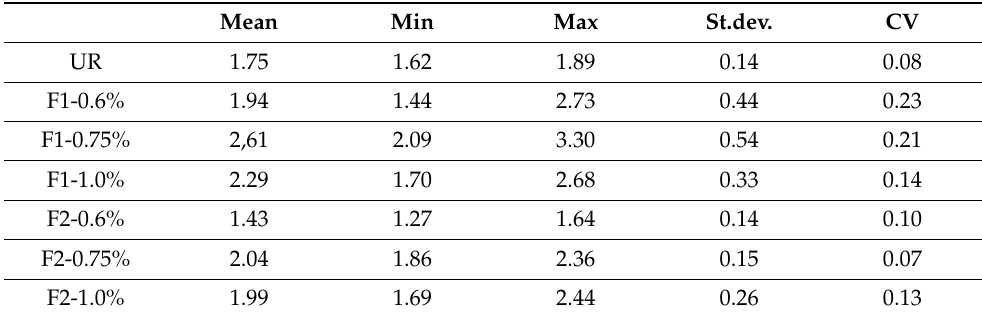
Table 8. Statistical data of the BTs. CV is the coefficient of variation. Mean Min Max St.dev.